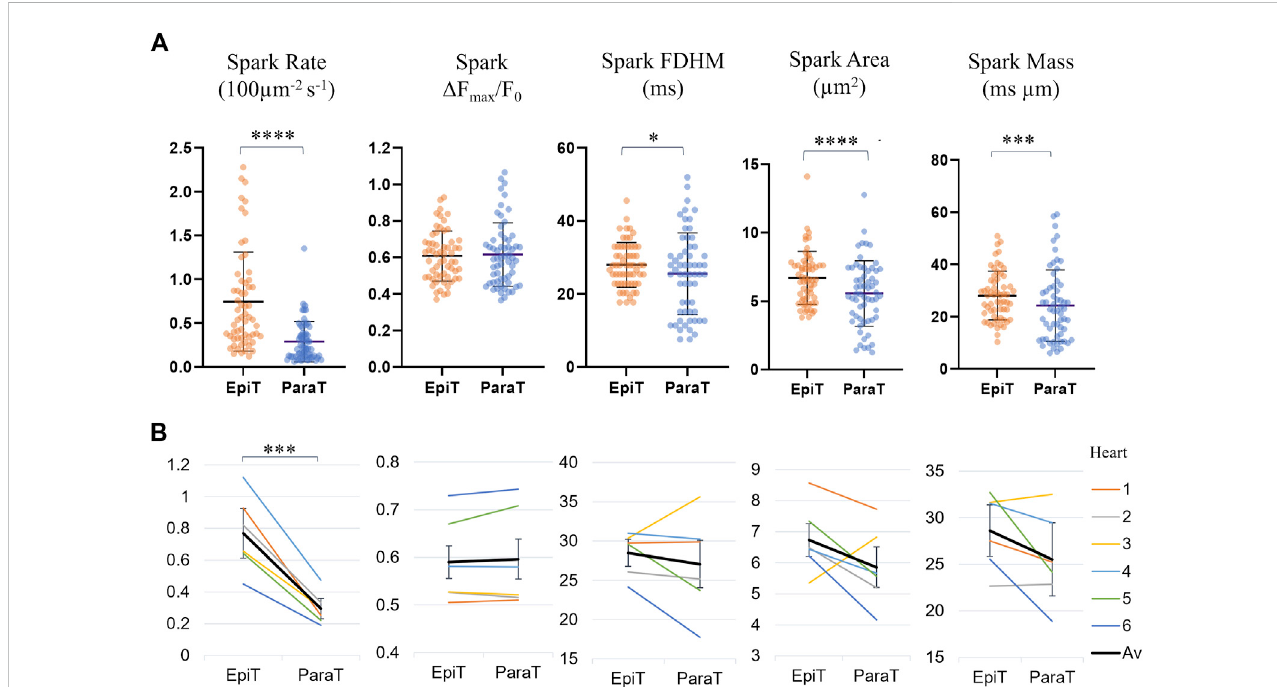
FIGURE 4 Spark parameters compared for epitubular (EpiT, DNT = 0) and paratubular (ParaT, 0 < DNT ≤ 5) regions. (A) Spark parameter distributions, with each datapoint corresponding to the median across epitubular (orange) and paratubular (blue) spark populations within each cell. The horizontal lines indicate the mean± SDover all cells( n =60).Thelevels ofsigni fi cance illustratedintheformofstars arebased onpaired testing(see SupplementaryTable S2). (B) Median sparkparameterforepitubularandparatubularsparkpopulationsineachcell,averagedforeachheart(1 – 6,seelegend).Theoverallaverage( “ Av ” )across thesixheartsisshowninblack. Theerrorbarsrepresentthestandarddeviationacrosstheheartaverages.Whencomparingcell-by-celldifferences,averaged for each heart using a one-sample t -test, only the spark rate is signi fi cantly different between epitubular and paratubular populations.